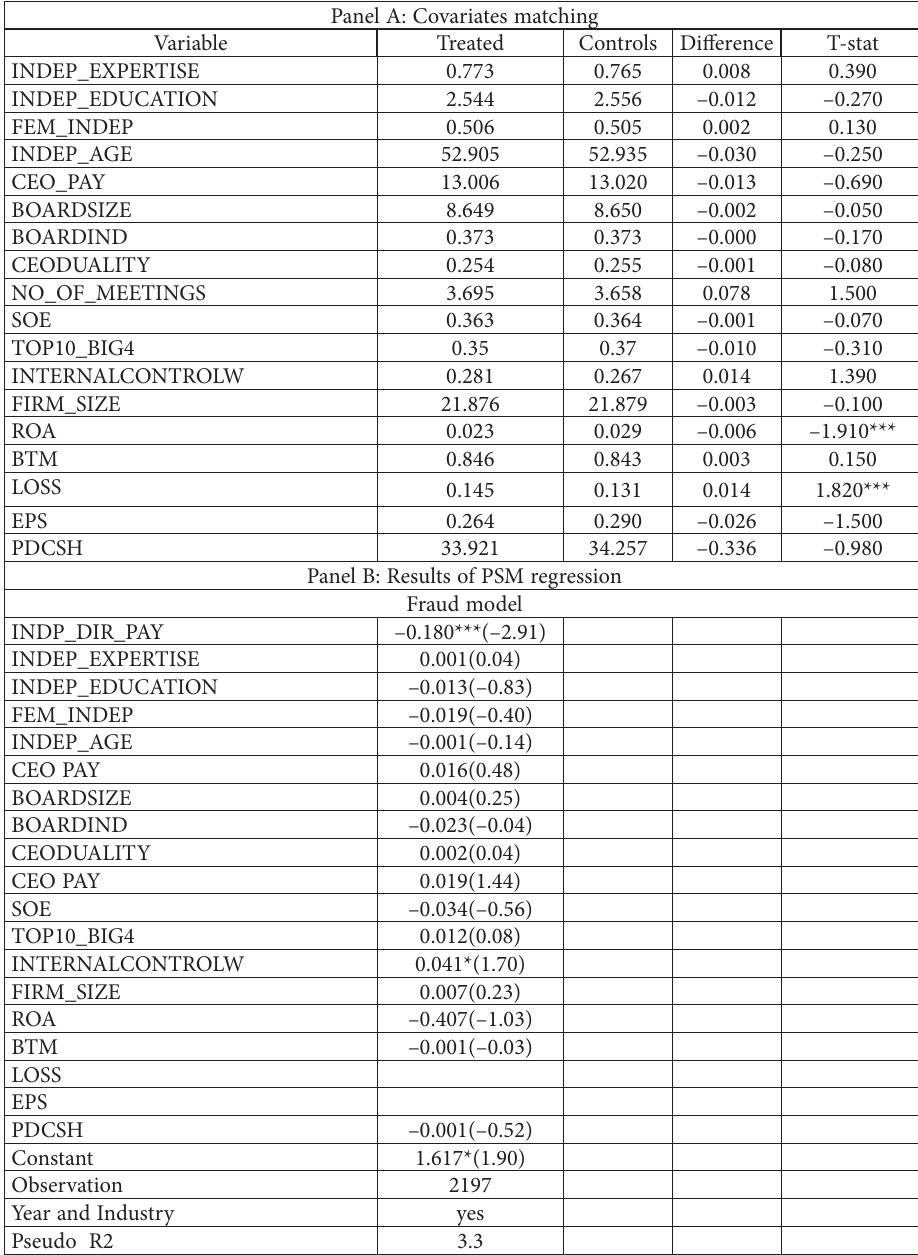
Table 5. Results of propensity score